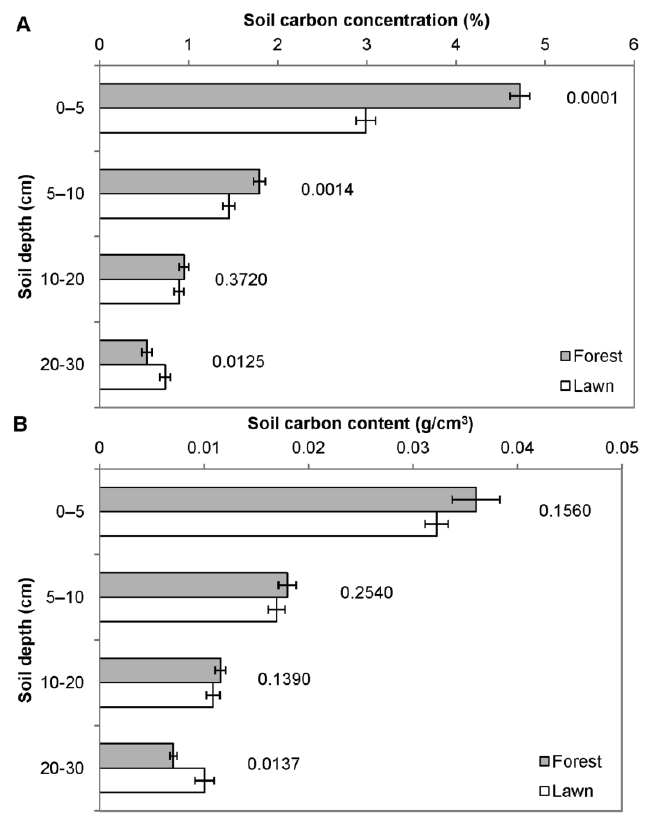
Figure 2. Correlation between soil carbon concentration in the upper 0–5 cm of lawn soil and time since land development for residential parcels developed in mixed oak forests in the Valley and Ridge physiographic province of southwest Virginia ( p = 0.0352).